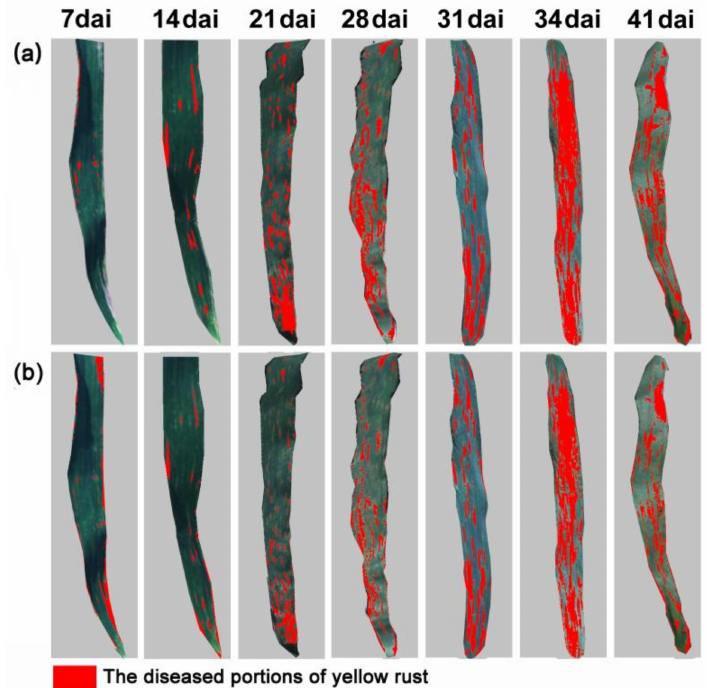
Figure 8. Extraction of rust diseased area produced by ( a ) WRSFs-based SVM and ( b ) VIs-based SVM from hyperspectral images of leaves at different